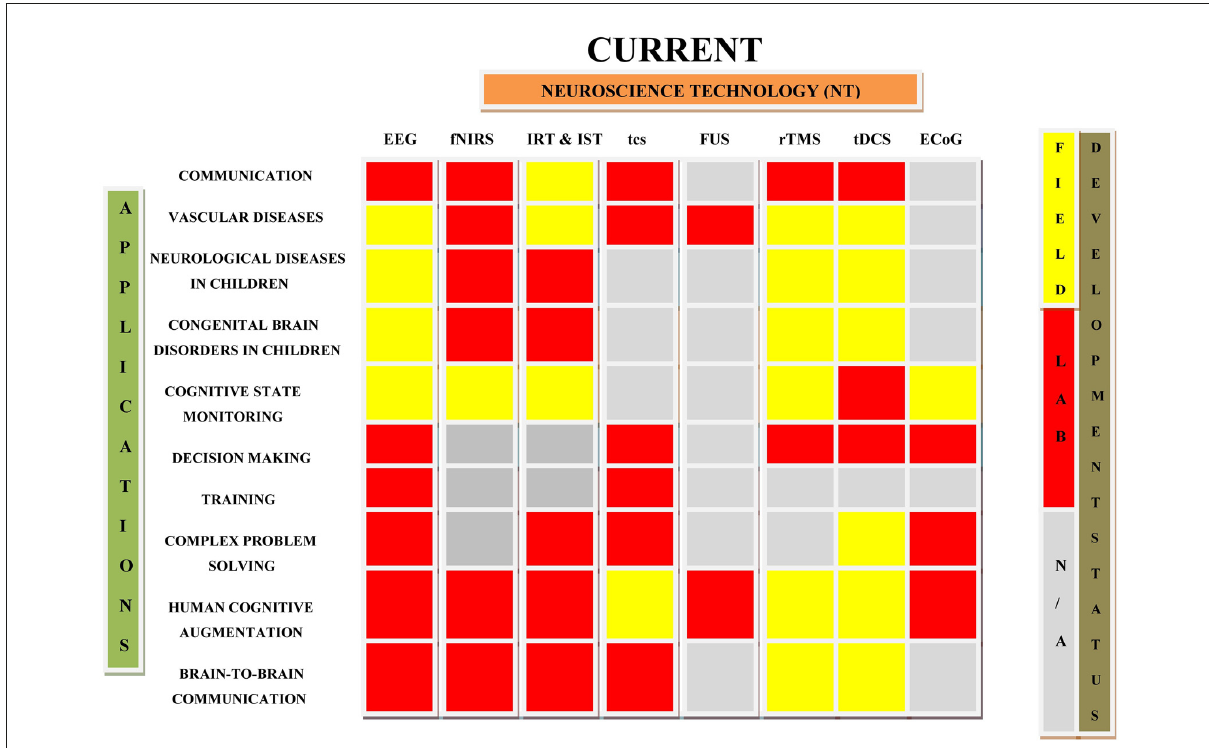
FIGURE3 Diagrammatic representation of current applications of neuroscience technologies in various fields. This draw highlights the roadmap of the developmentofneurosciencetechnologiesandtheircurrentapplicationsindifferentconditions.IRT,InvasiveRecordingTechnology;IST,Invasive Stimulation Technology (Cinel et al.,